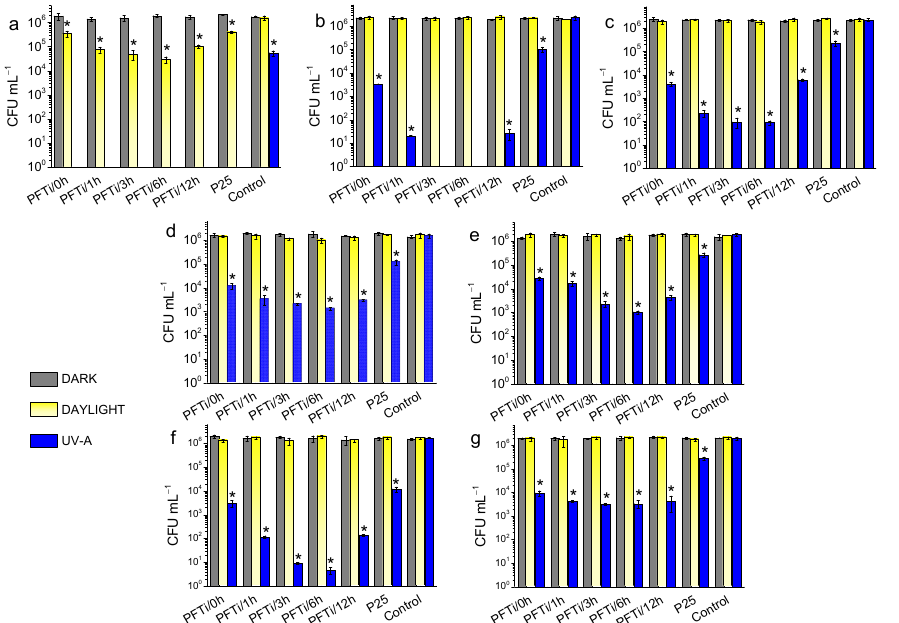
Figure 2. Figure 2. Antibacterial activities of the hydrothermally prepared PF-co-doped TiO 2 nanoparticles on the foodborne pathogenic bacteria Campylobacter jejuni ( a ), Salmonella Typhimurium ( b ), Enterohaem- orrhagic E. coli ( c ), Yersinia enterocolitica ( d ), Shewanella putrefaciens ( e ), Listeria monocytogenes ( f ) and Staphylococcus aureus ( g ). Experiments were performed under dark conditions or daylight or UVA exposures for 30 min. Starting CFUs were ~10 6 CFU mL − 1 . The concentration of PF-TiO 2 NPs was 500 µ g/mL. Lack of the blue column demonstrated the complete elimination of the treated bacteria. * Significant difference at p <